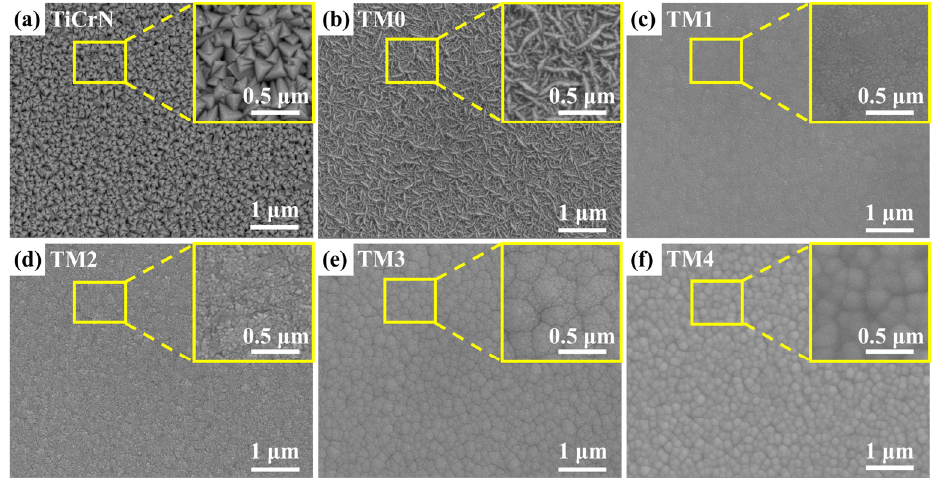
Figure 4. Surface topography of ( a ) TiCrN, ( b ) TM0, ( c ) TM1, ( d ) TM2, ( e ) TM3, and ( f ) TM4 coatings.